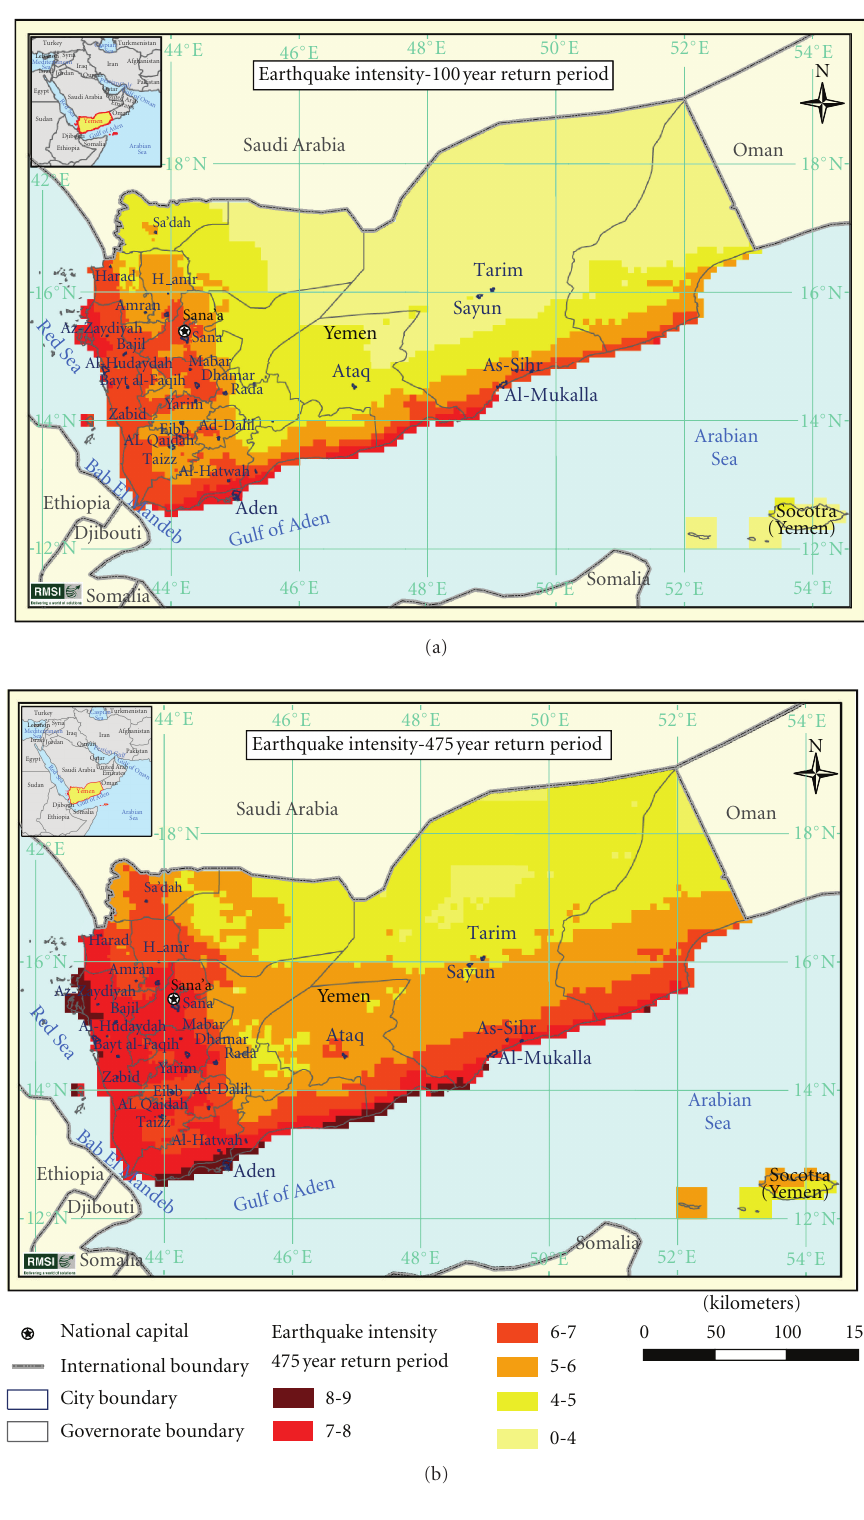
Figure 12: 100- and 475-year return period probabilistic seismic hazard maps for earthquake intensity in